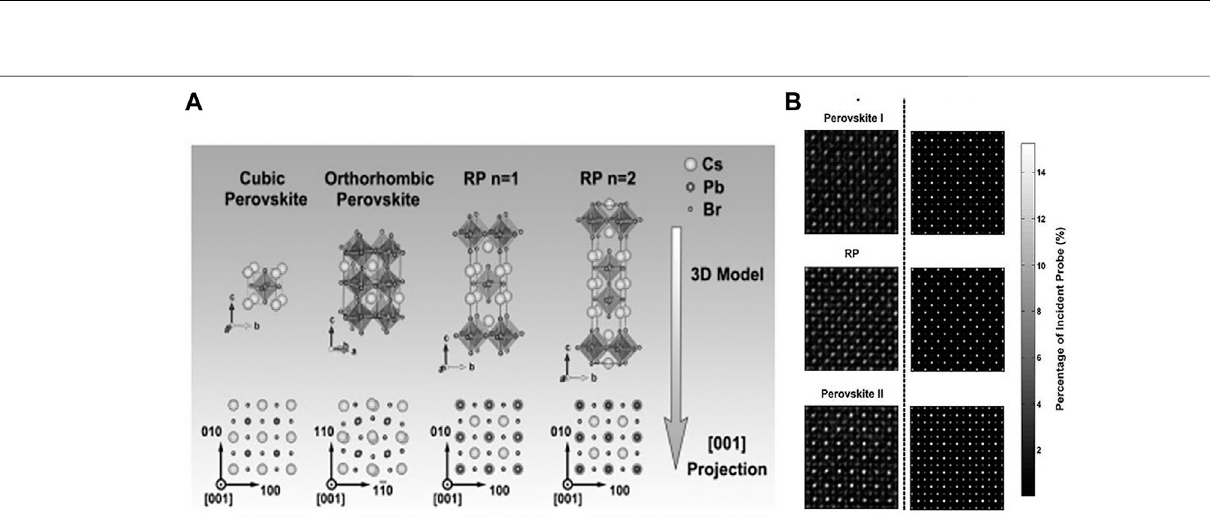
FIGURE 2 | (A) Upper panel: conventional crystallographic structure of cubic and orthorhombic CsPbBr 3 perosvskite phases along with RP phases (for different values of n (cid:1) 1 and n (cid:1) 2). Lower panel: unit cells and their projections along the [001] direction. (B) Atomic structures of the domains (plausible RP) and the domain boundaries (between the phases of conventional perovskites and RP) and the comparison between the experimental and simulated STEM images. Pure Cs and mixed Pb – Br cation columns are present along the [001] projected direction in conventional 3D structures of perovskite phases, as compared to the all-mixed Cs – Pb – Br cationcolumninRPphasesalongthesameprojecteddirection.The fi